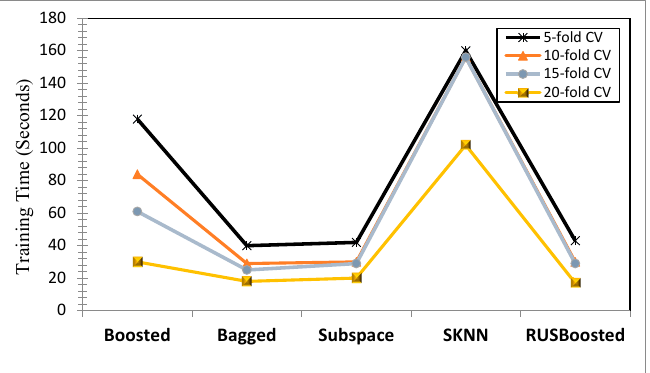
Figure 5. Training time comparison for various ensemble models with different CV.